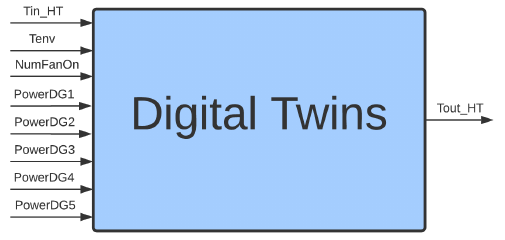
Figure 3. Digital Twins of cooling